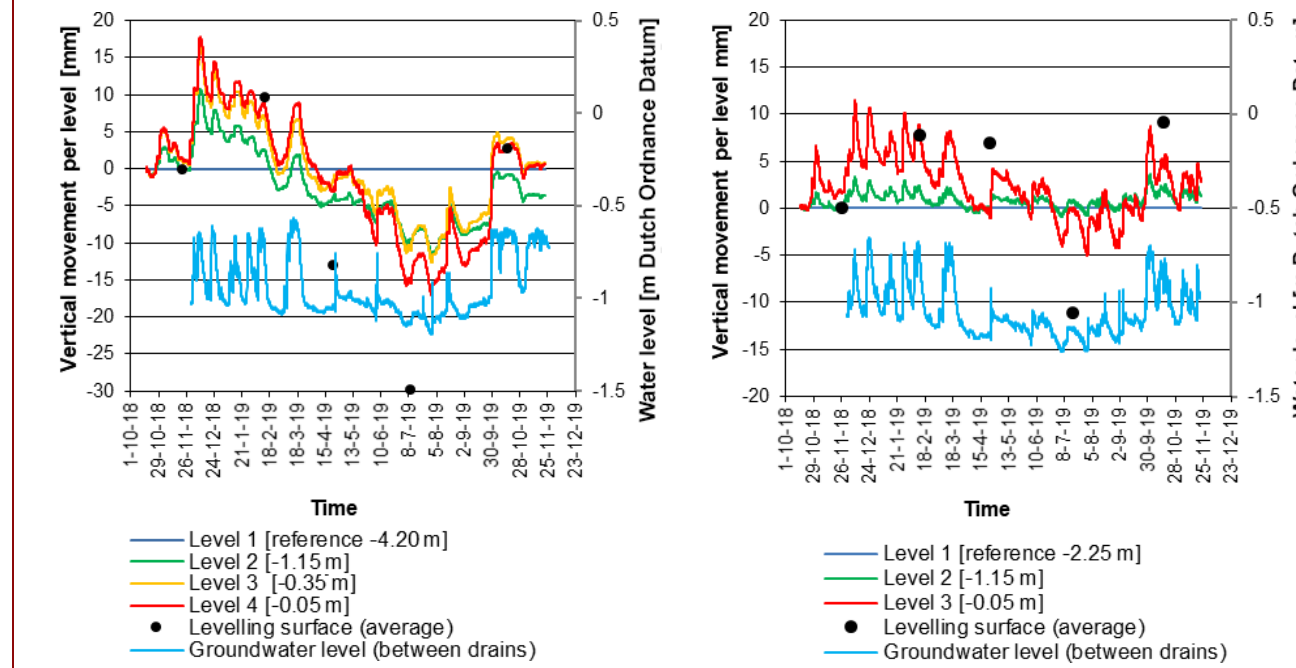
Figure 4. Preliminary results of extensometer, levelling and groundwater level measurements (parcel 09-DR; Fig.